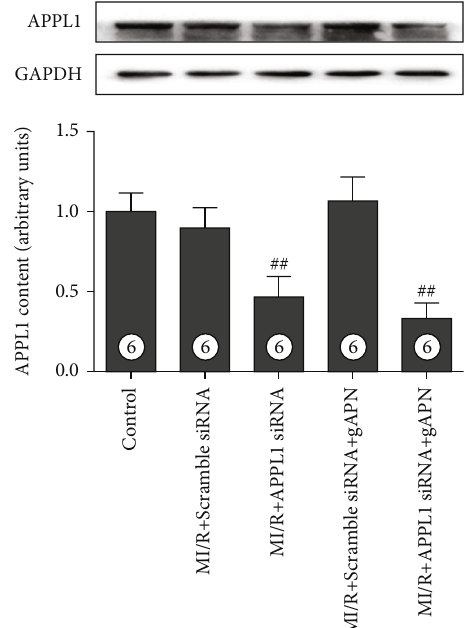
Figure 2: Interaction of AdipoR1 and APPL1 was blunted in HD induced type-2 diabetic heart in mice. Western blot analysis for APPL1. APPL1 expression was compared for groups with or without APPL1 siRNA. ∗∗ P < 0 : 01 vs. the same treatment group without APPL1